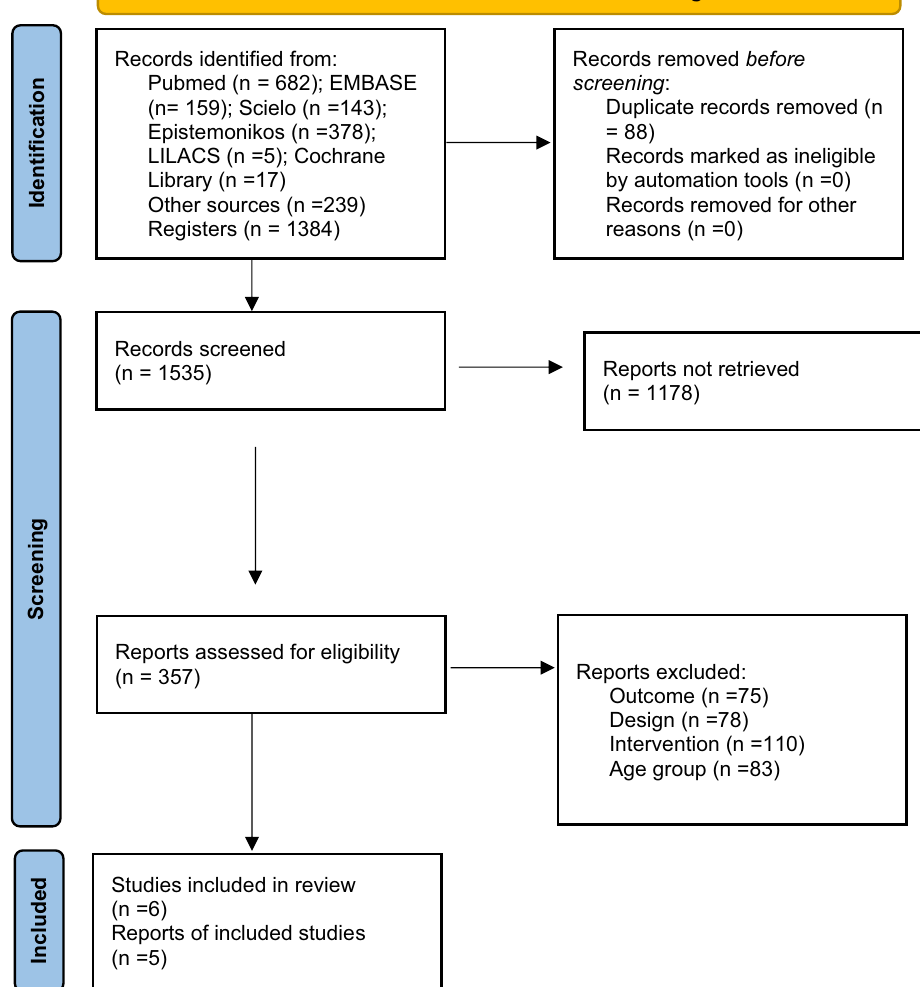
Figure 1. PRISMA flowchart of selection of articles included in the systematic review. Adapted from: Page MJ, McKenzie JE, Bossuyt PM, Boutron I, Hoffmann TC, Mulrow CD, et al. The PRISMA 2020 statement: an updated guideline for reporting systematic reviews. BMJ 2021;372:n71. https:// doi. org/ 10. 1136/ bmj. n71. For more information, visit: www. prisma- state ment.